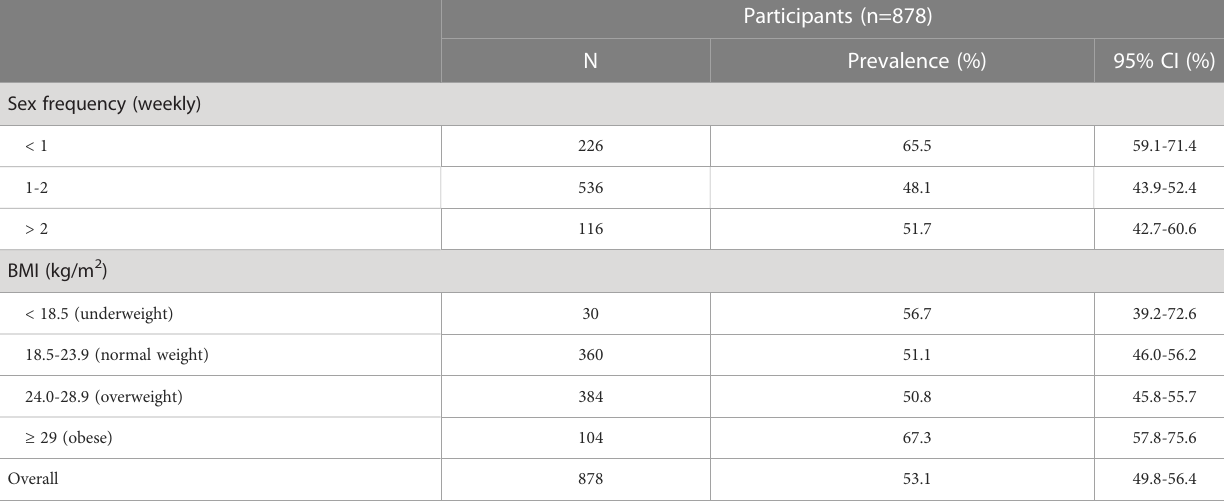
TABLE 2 Prevalence of ED according to sex frequency and BMI category.